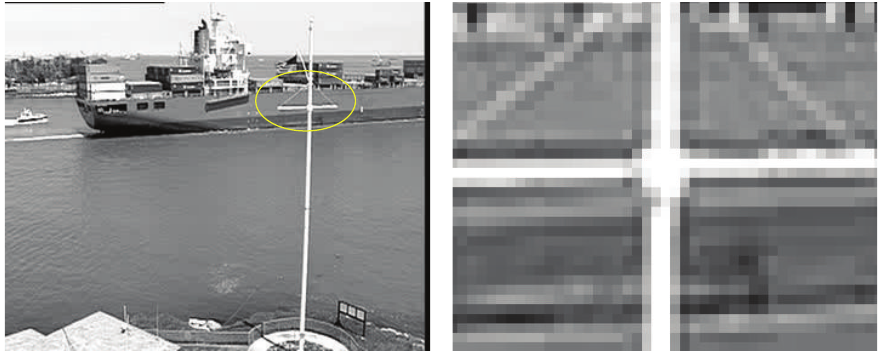
Figure 3: Sample frame with a thin object of bright color.